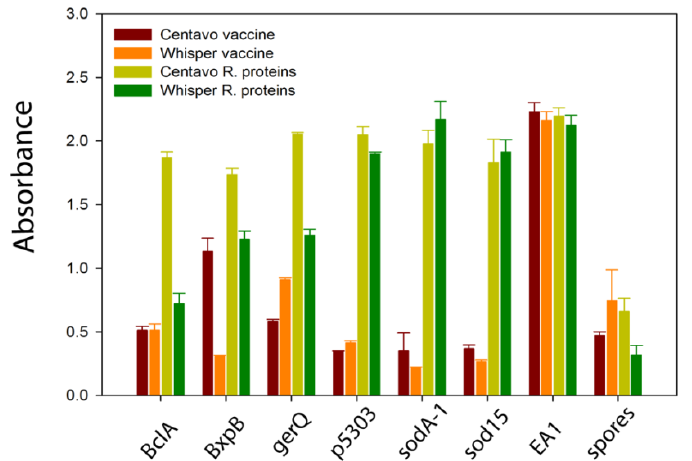
Figure 1. Binding of polyclonal antibodies from the plasma of two llamas, Centavo and Whisper, after immunization with the veterinary anthrax vaccine (red and orange) and after additional immunizations with recombinant B. anthracis spore proteins (yellow and green). Binding is shown for the six recombinant spore proteins, the EA1 S-layer protein, and B. anthracis spores